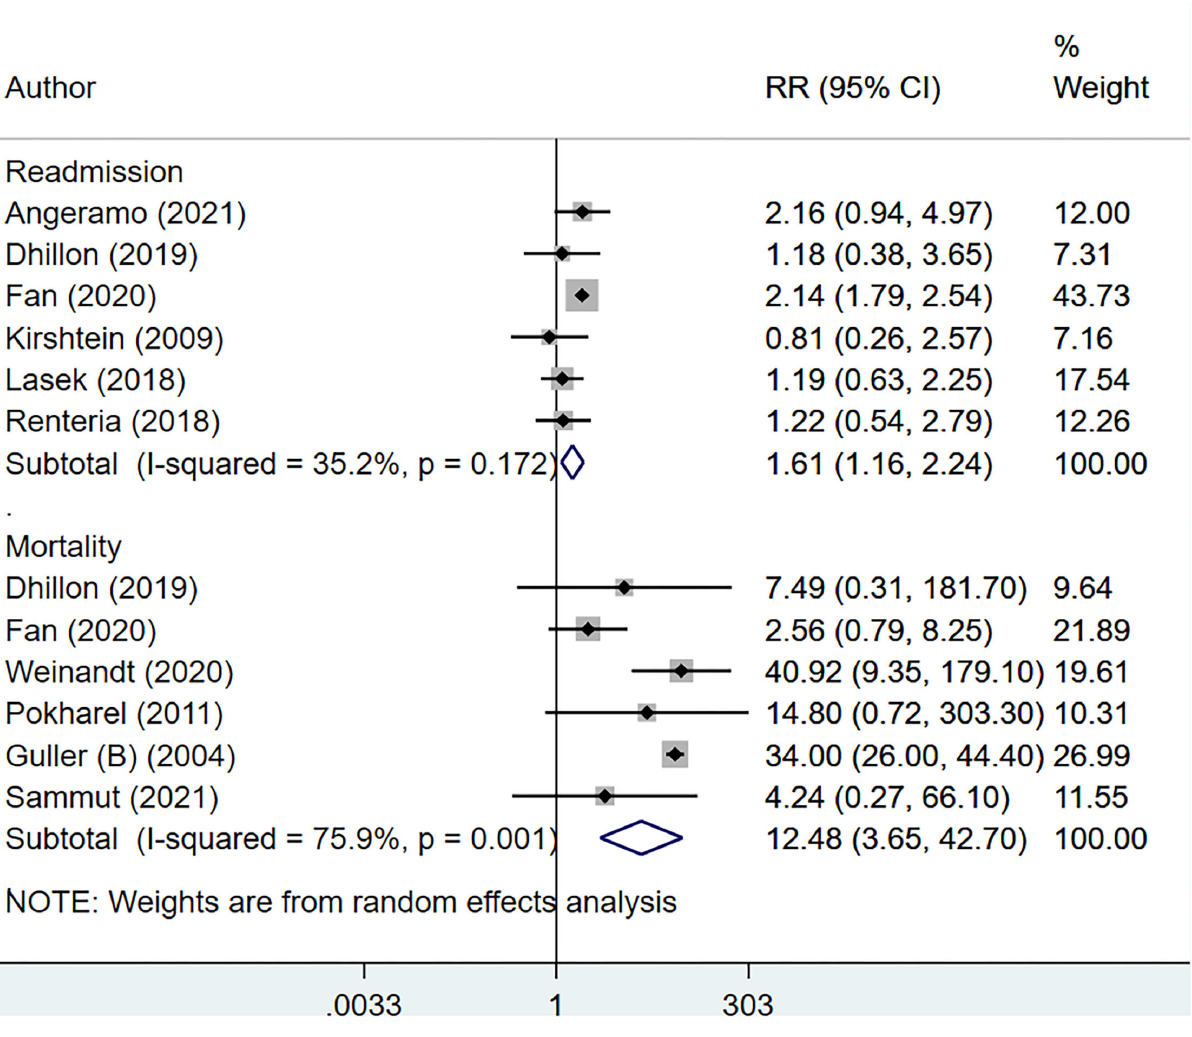
outcomes analyzed, there was no evidence of publication